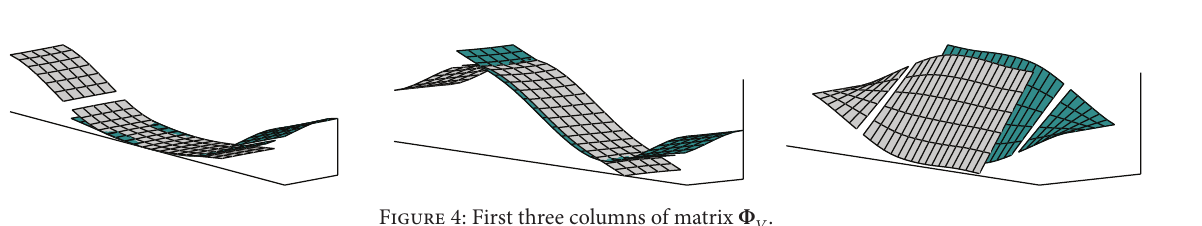
Figure 3: Constraint modes along y and around x of friction bar.